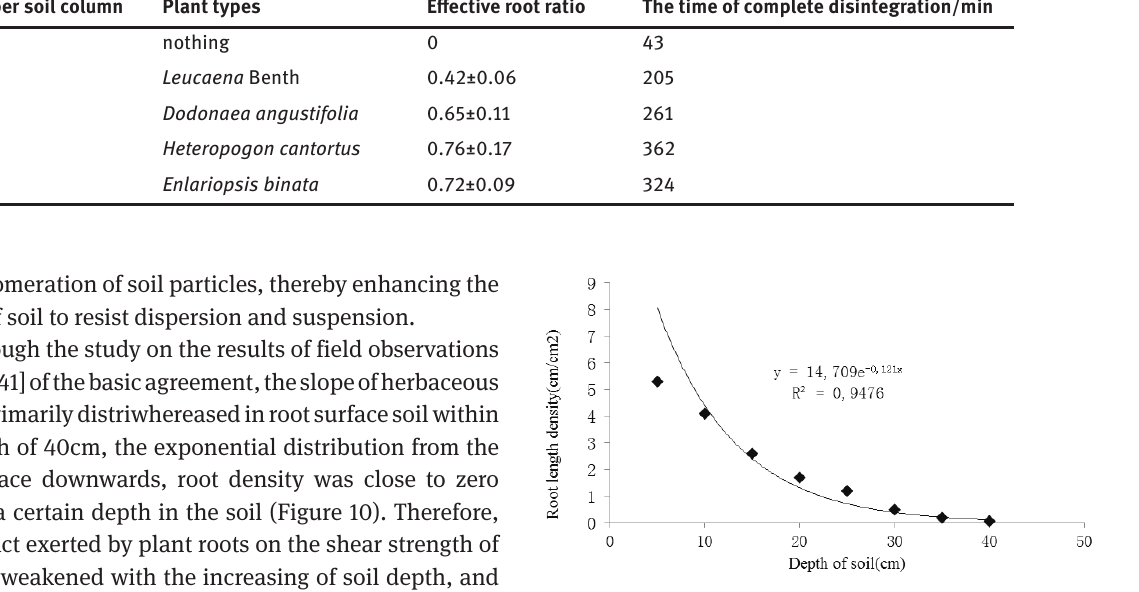
Table 7: The time of complete disintegration of soil under different effective root ratio conditions. The number soil column